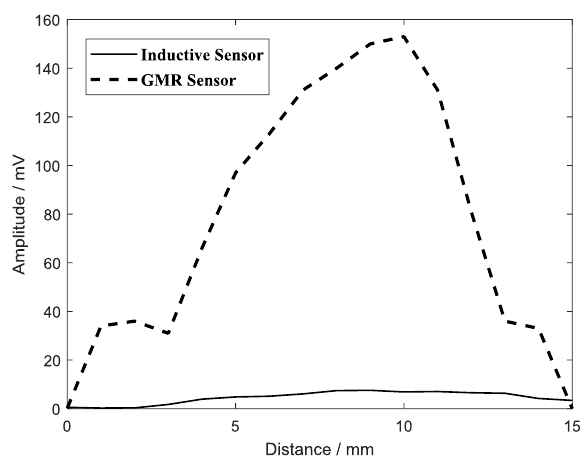
FIGURE 10. Giant magnetoresistance and inductive output voltage.